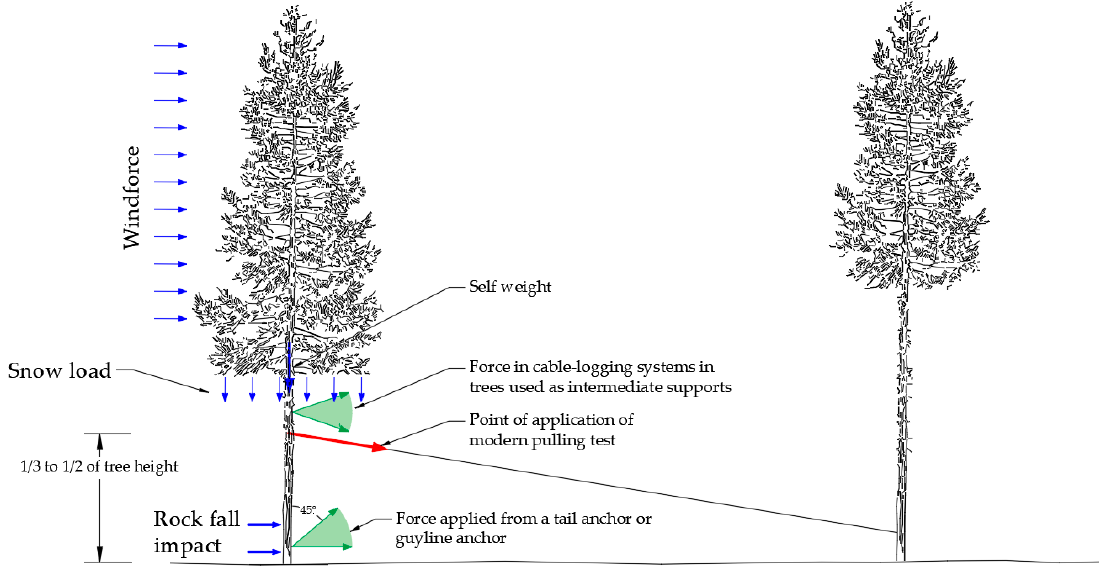
Figure 3. Schematic representation of a tree pulling tests with the typical pulling height. Typical applied loads from cable logging systems (green arrows) and commonly investigated loading conditions from literature (blue arrows).